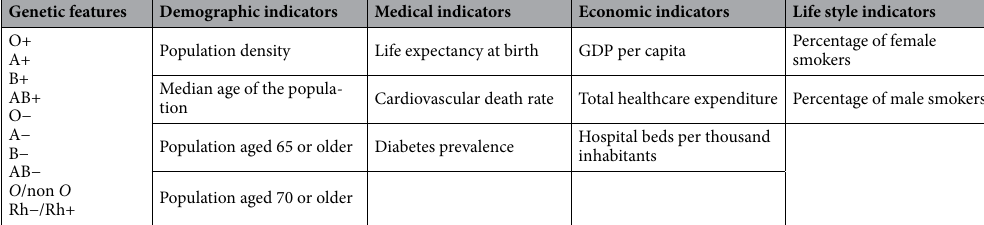
Table 1. List of input features. We used five kinds of features: genetic, demographic, economic, medical, and life style